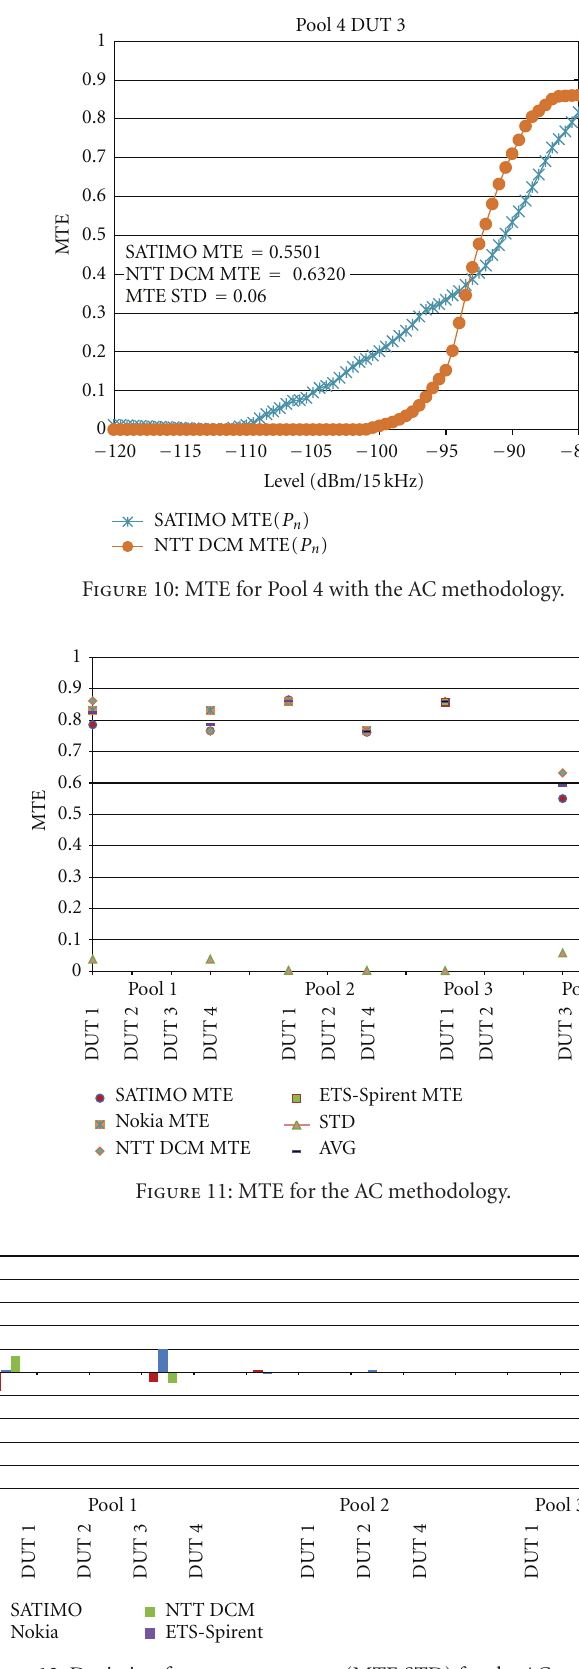
Figure 12: Deviation from group average (MTE STD) for the AC